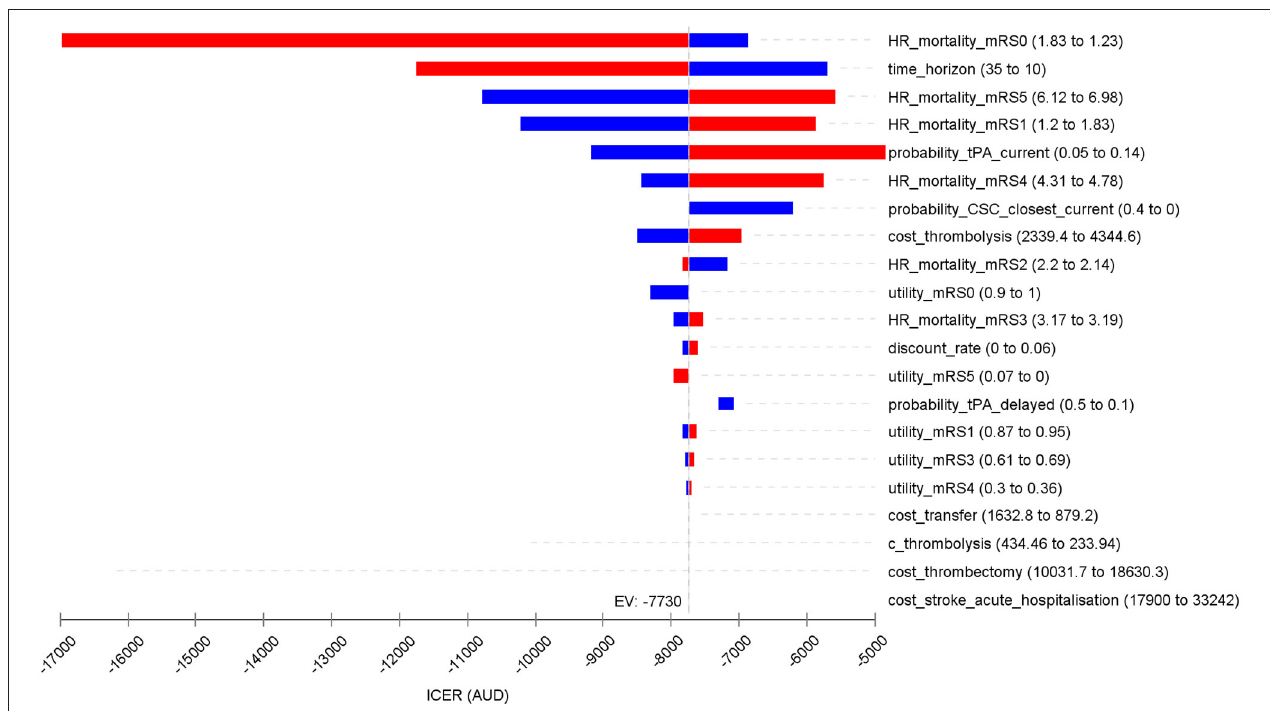
FIGURE 2 | Tornado diagram for the one-way sensitivity analysis showing the variation in the basecase cost-effectiveness results. Slight difference in the ICER (EV) with the abstract and Table 3 (incremental QALY 0.0058 and cost saving of $44.76 per patient) was due to different decimal points.